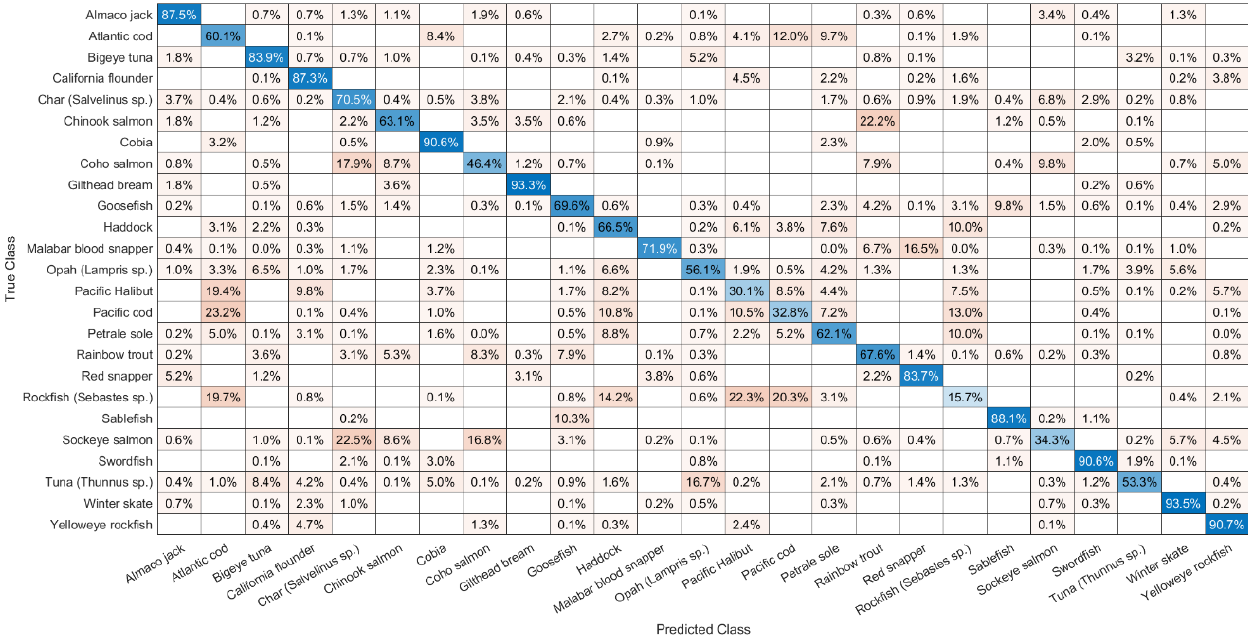
Figure 12. Confusion matrix for the single-mode SWIR results with the k = 7 MLP (overall classification accuracy = 67.6%). The variability of these single-mode classification results with each of the four cross- validation folds can be seen in Figure 13. The lower and upper limits of the error bars in each plot represent the minimum and maximum accuracies, respectively, for the four-folds. The red dashed line in each plot represents the benchmark accuracy obtained by MLP using all wavelengths in the spectrum.